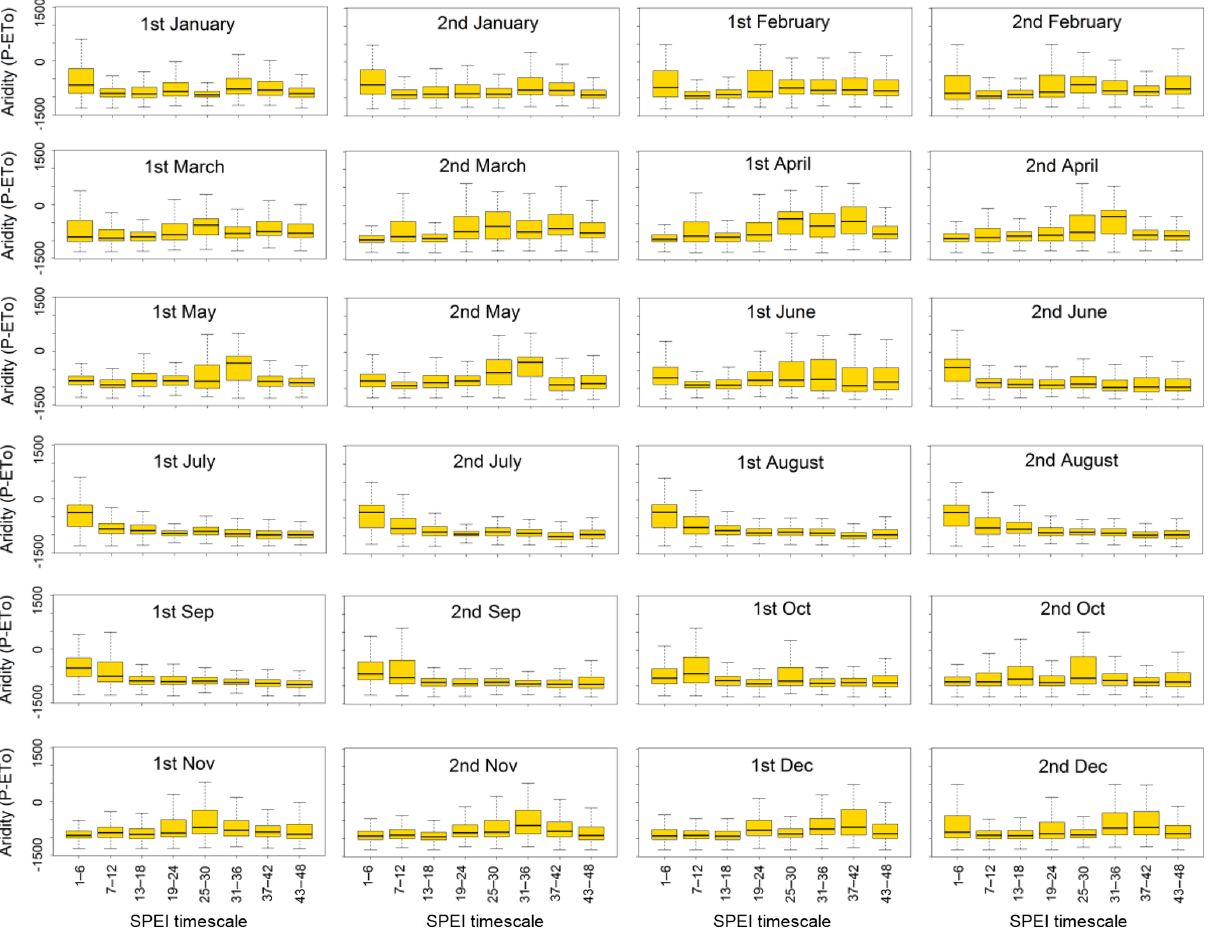
Figure 10. Box plots showing the climate aridity values, as a function of the SPEI timescales at which the maximum correlation between the sNDVI and SPEI is